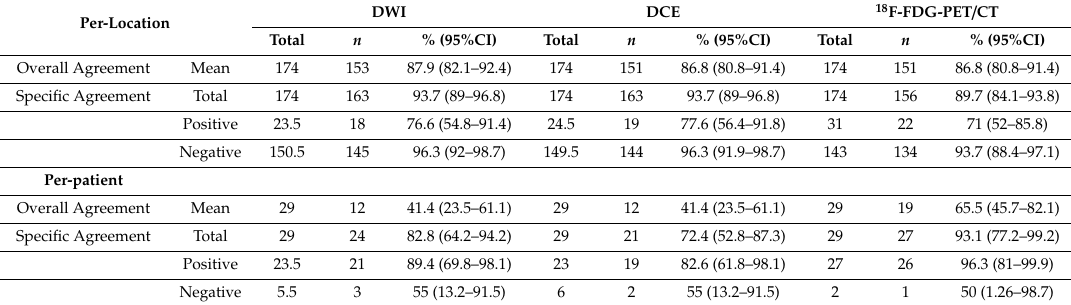
Abbreviations: 95%CI = 95% Confidence